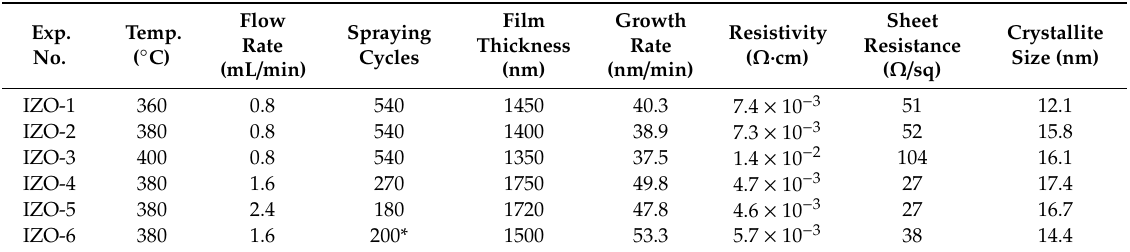
Table 1. Film properties for variations in deposition temperature and solution flow rate. IZO, indium- doped zinc oxide.